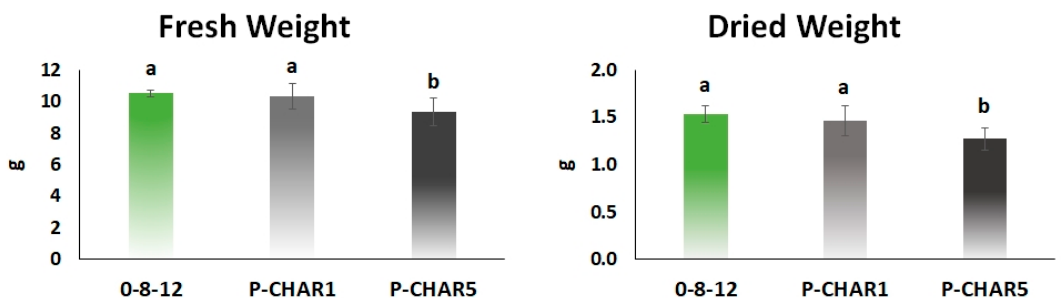
Figure 1. Fresh and dried weight of wheat plants supplied with 0-8-12 conventional NKP fertilizer, P-CHAR1, and P-CHAR5. Different letters indicate significant differences among treatments.